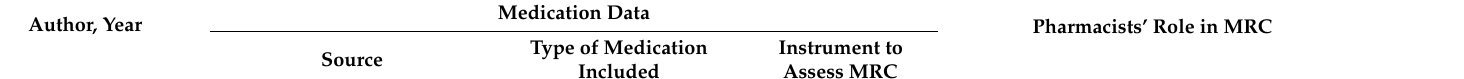
Table 2. Description of the included studies: medication data, pharmacists’ role and main